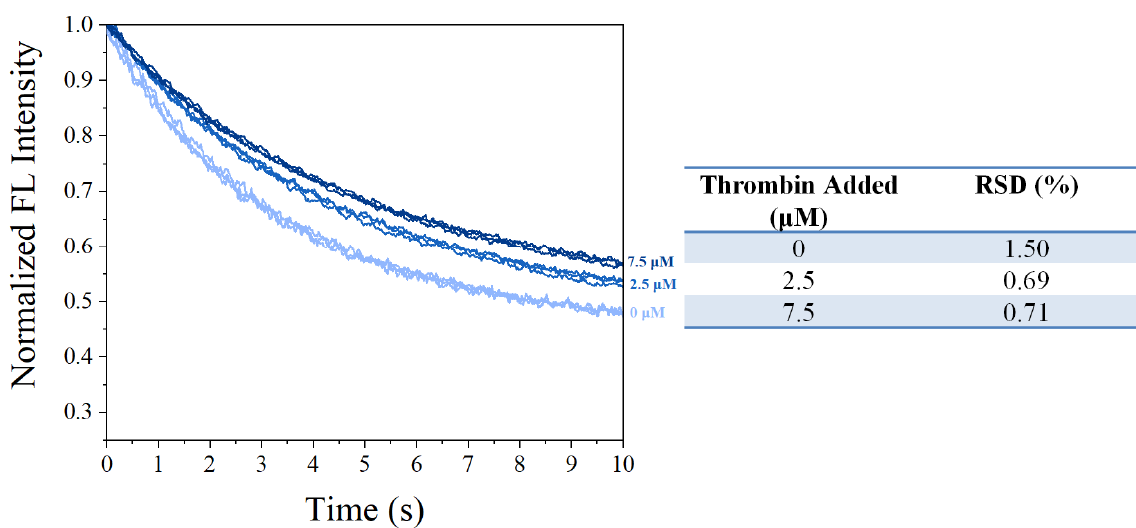
Figure 7. Repeatability measurements on fluorescence attenuation curves of SITS-Thrombin27 5 ′ in the presence of 0, 2.5, and 7.5 μ M of thrombin, respectively.